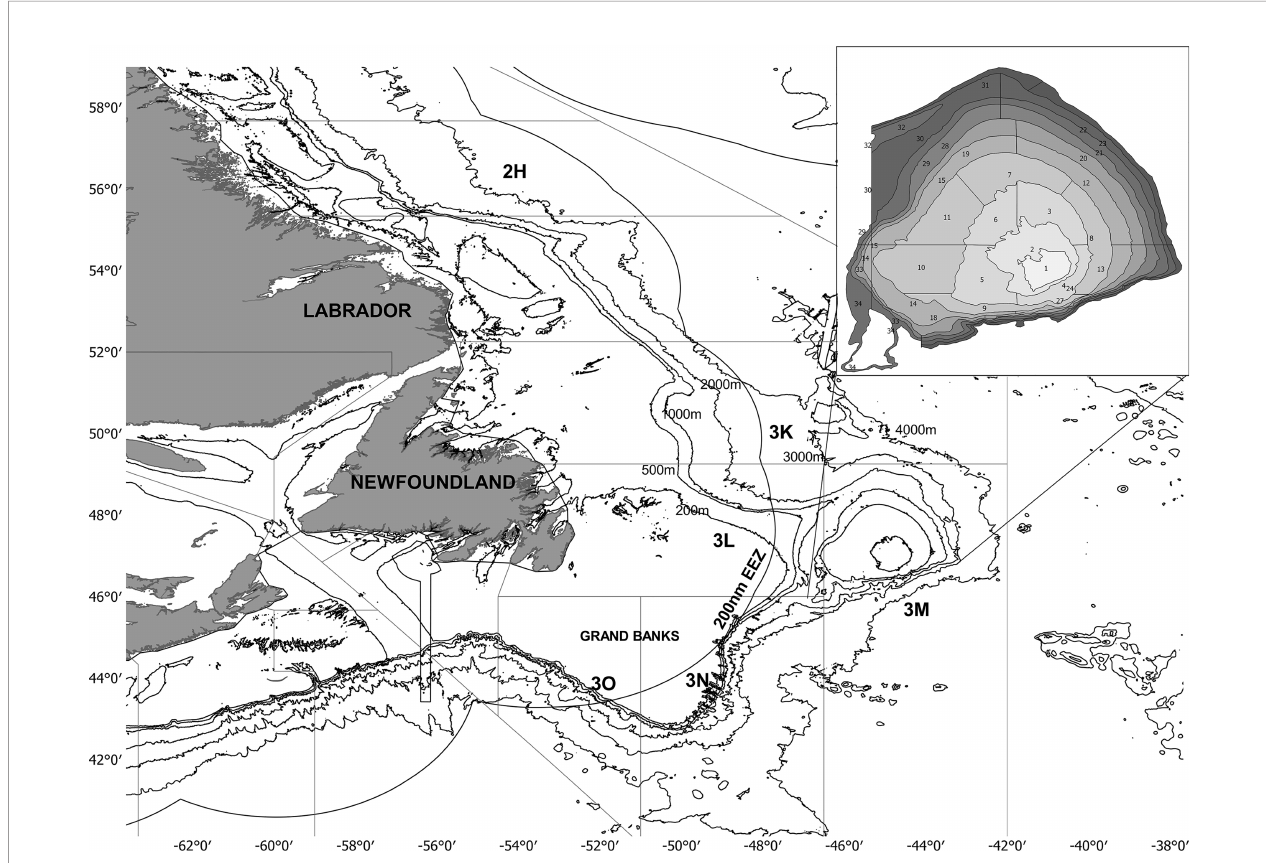
FIGURE 1 | Map of Newfoundland and Labrador waters. Lines indicated isobaths (200, 500, 1000, 2000, 3000 and 4000 m depth). Fisheries management units in which the continental shelf is divided are identi fi ed with the following letters: 2H, 3K, 3L, 3M, 3N and 3O. The Flemish cap has been zoomed in the upper right panel to show strata division (total: 32 strata). Source: Adapted from Pe ́ rez-Rodr ı ́ guez,